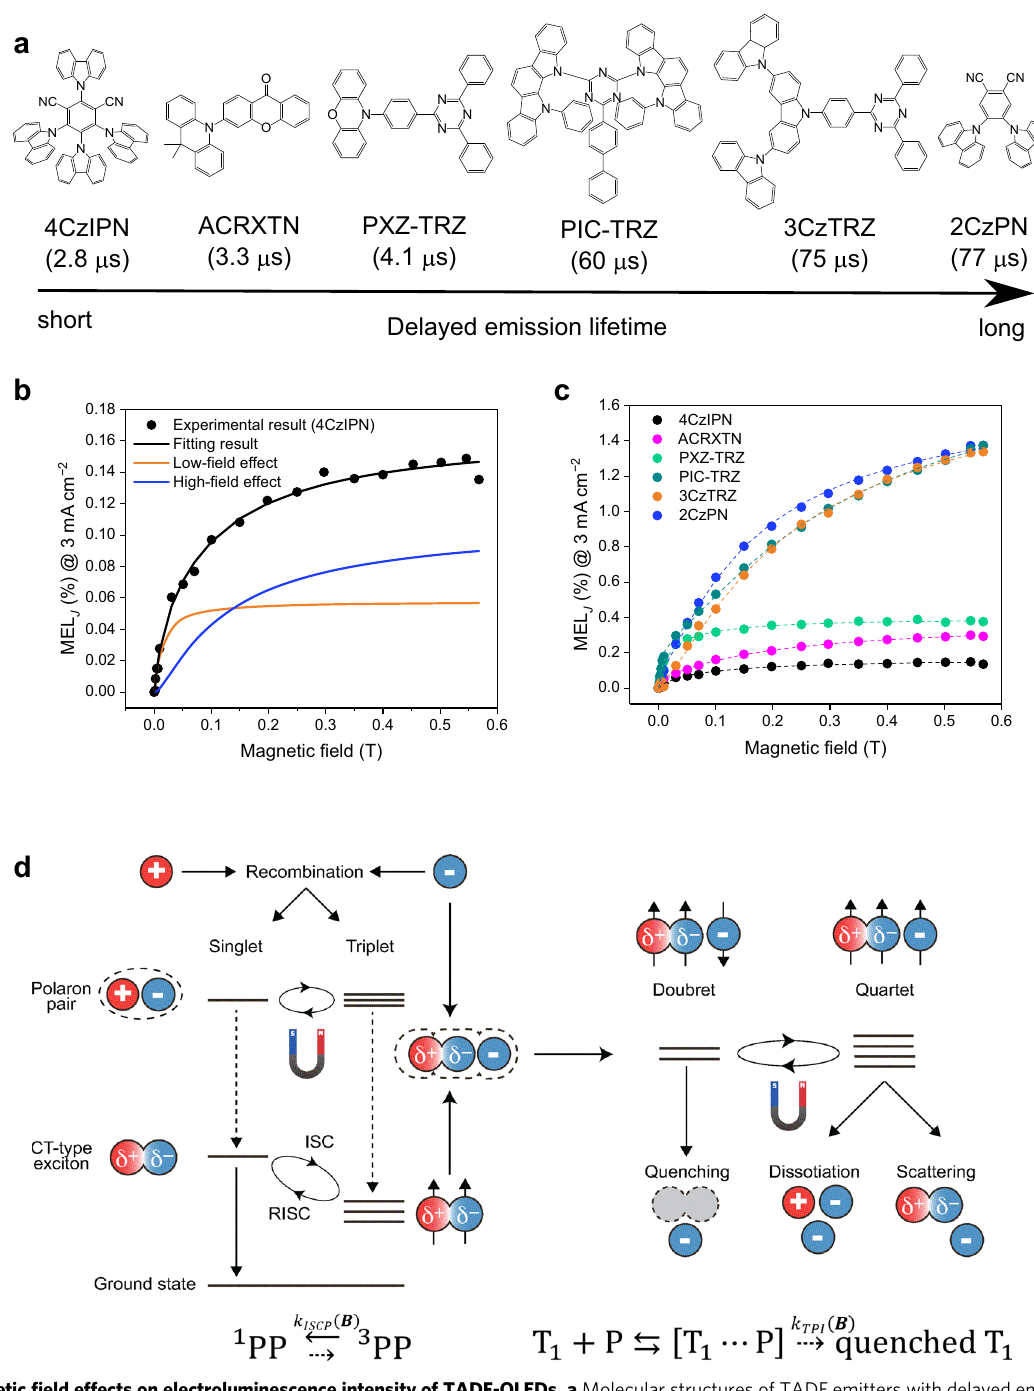
Fig. 1 Magnetic fi eld effects on electroluminescence intensity of TADF-OLEDs. a Molecular structures of TADF emitters with delayed emission lifetimes. b Fit of magneto-electroluminescence pro fi le of 4CzIPN-based OLED under constant 3.0 mA cm − 2 current into low- fi eld and high- fi eld effects. c Magneto- electroluminescence pro fi les of various TADF-OLEDs. The dashed lines are fi ts. d Schematic of triplet-polaron interaction (TPI) in OLEDs under electrical excitation. A magnetic fi eld suppresses the intersystem crossing of the polaron-pair state (small intersystem crossing rate, k ISCP ) and the triplet – polaron interaction (small triplet polaron interaction rate, k TPI ). [T 1 ⋯ P] represents a trion intermediate